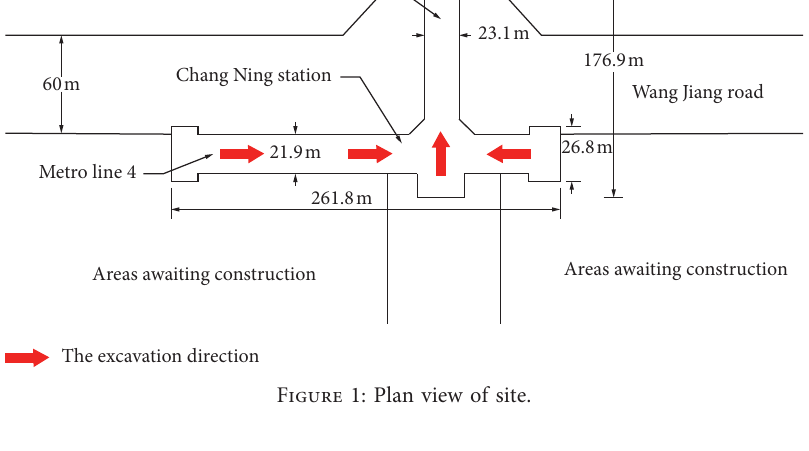
Figure 1: Plan view of site.